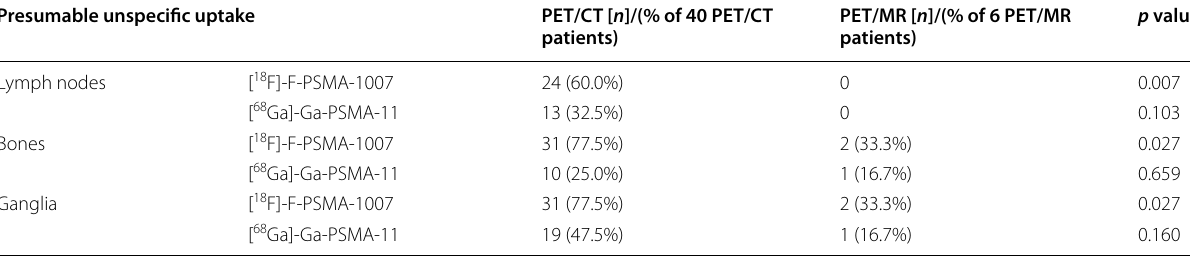
PET/MR [ n ]/(% of 6 PET/MR p value patients) patients)